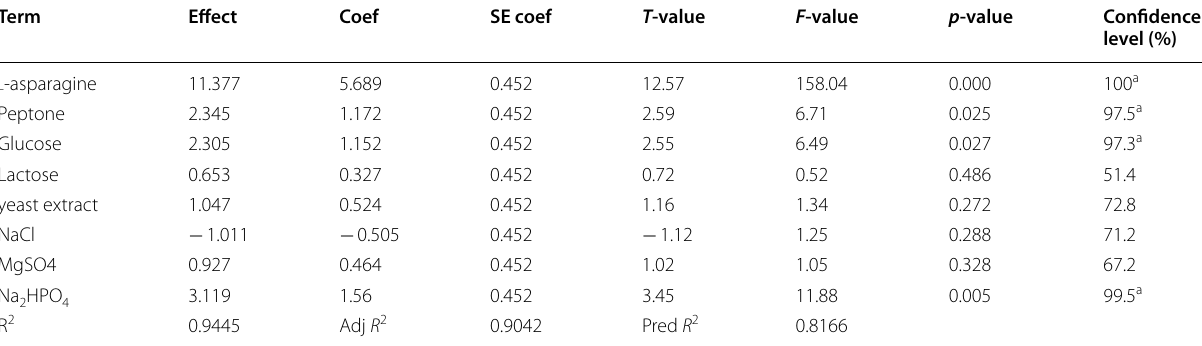
a Statistically significant at 95% confidence level